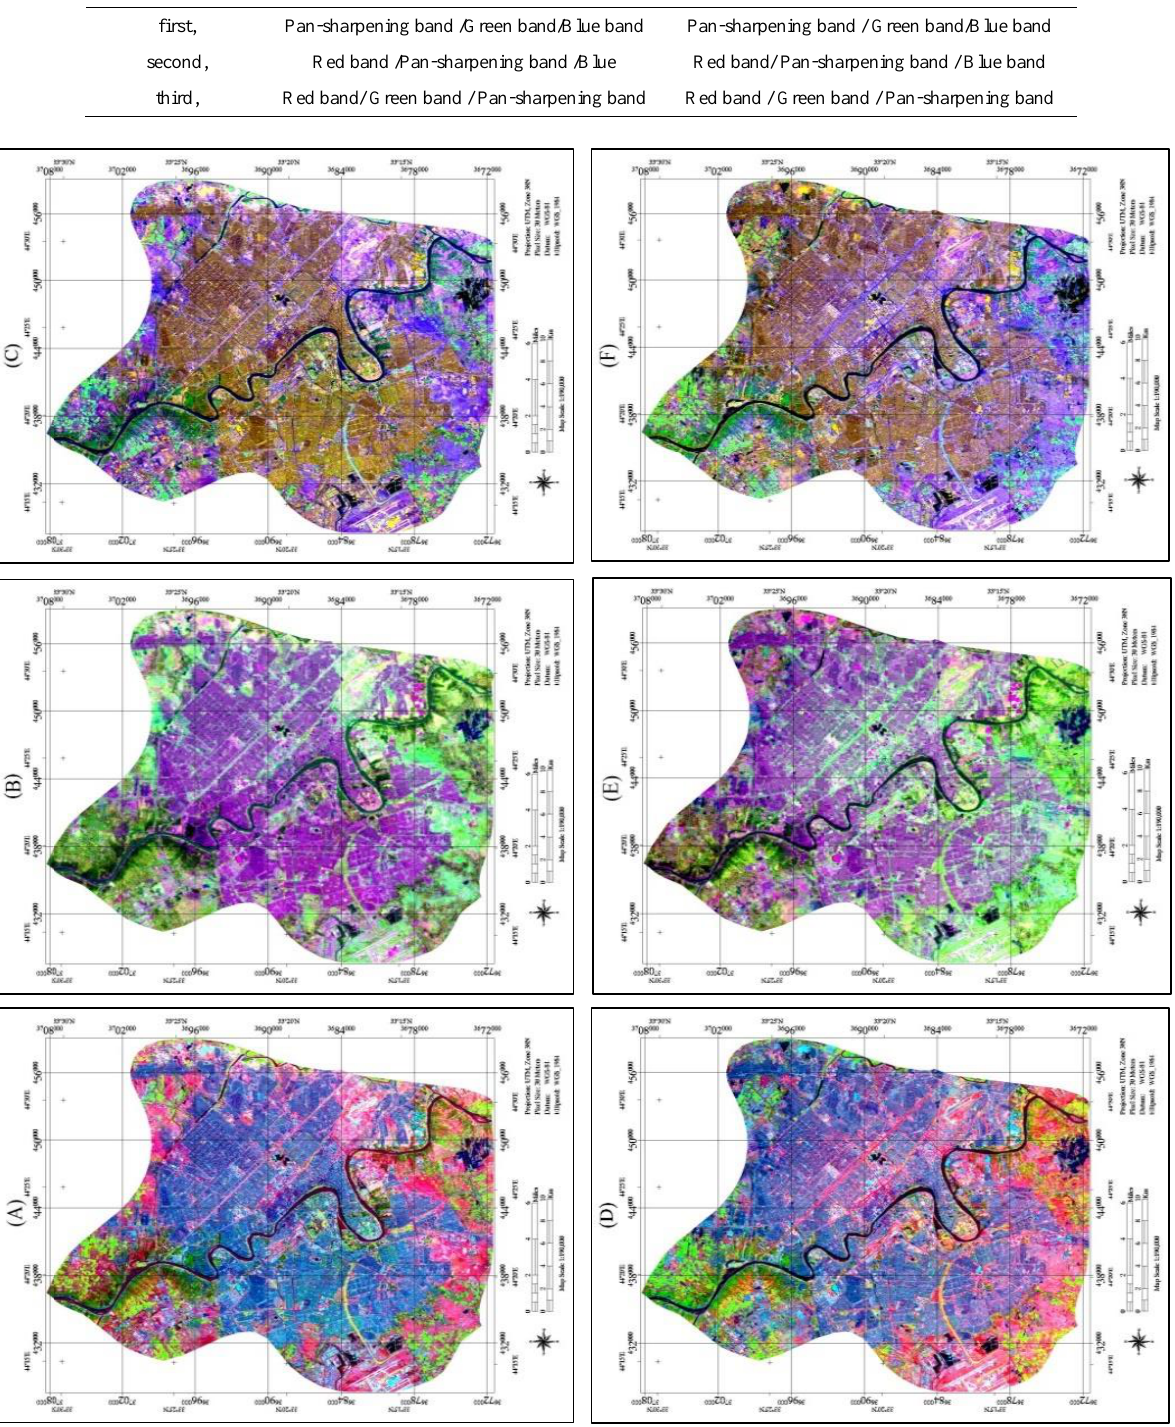
Figure 5. The false-colored images of the combination between the visible with pan-sharpening bands (A) image combination of (Pan-sharpening band / Green band/Blue band) of 2015, (B) image combining of (Red band / Pan-sharpening band/ Blue) of 2015, (C) image combining of (Red band / Green band / Pan-sharpening band) of 2015, (D) image combining of (Pan- sharpening band / Green band/Blue band) of 2020, (E) image combining of (Red band / Pan-sharpening band / Blue) of 2020, (F) image combining of (Red band /Green band/ Pan-sharpening band) of